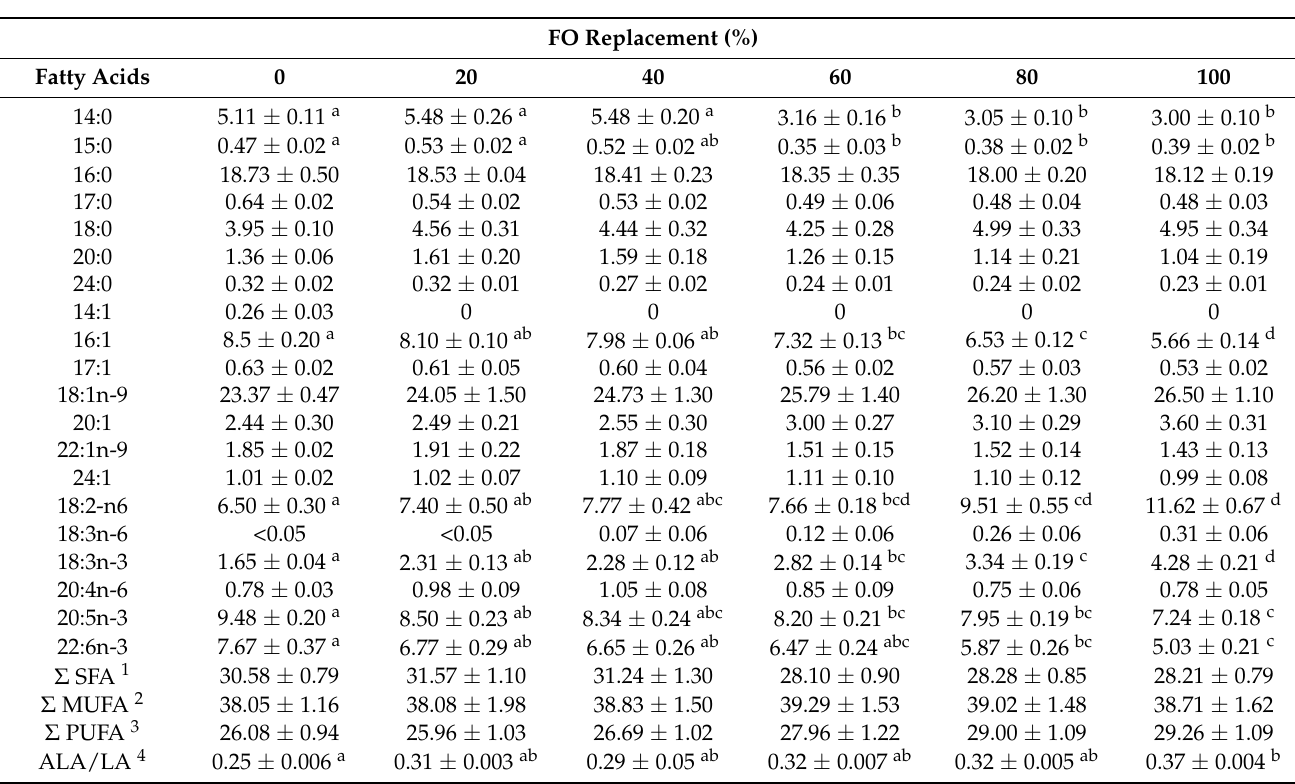
Table 3. Fatty acid profile (% of total lipid content) of the practical diets with different levels of replacement of cod liver oil by a blend of vegetable